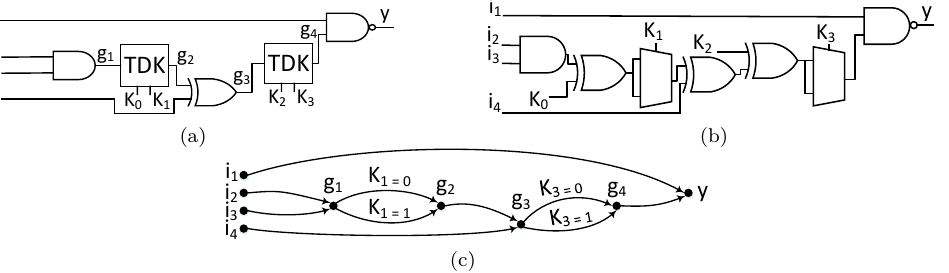
Figure 8: Converting a (a) netlist obfuscated with TDK cells to a (b) Key Programmable Circuit (KPC), and (c) the representative graph of the netlist annotated with TDK cell delays.